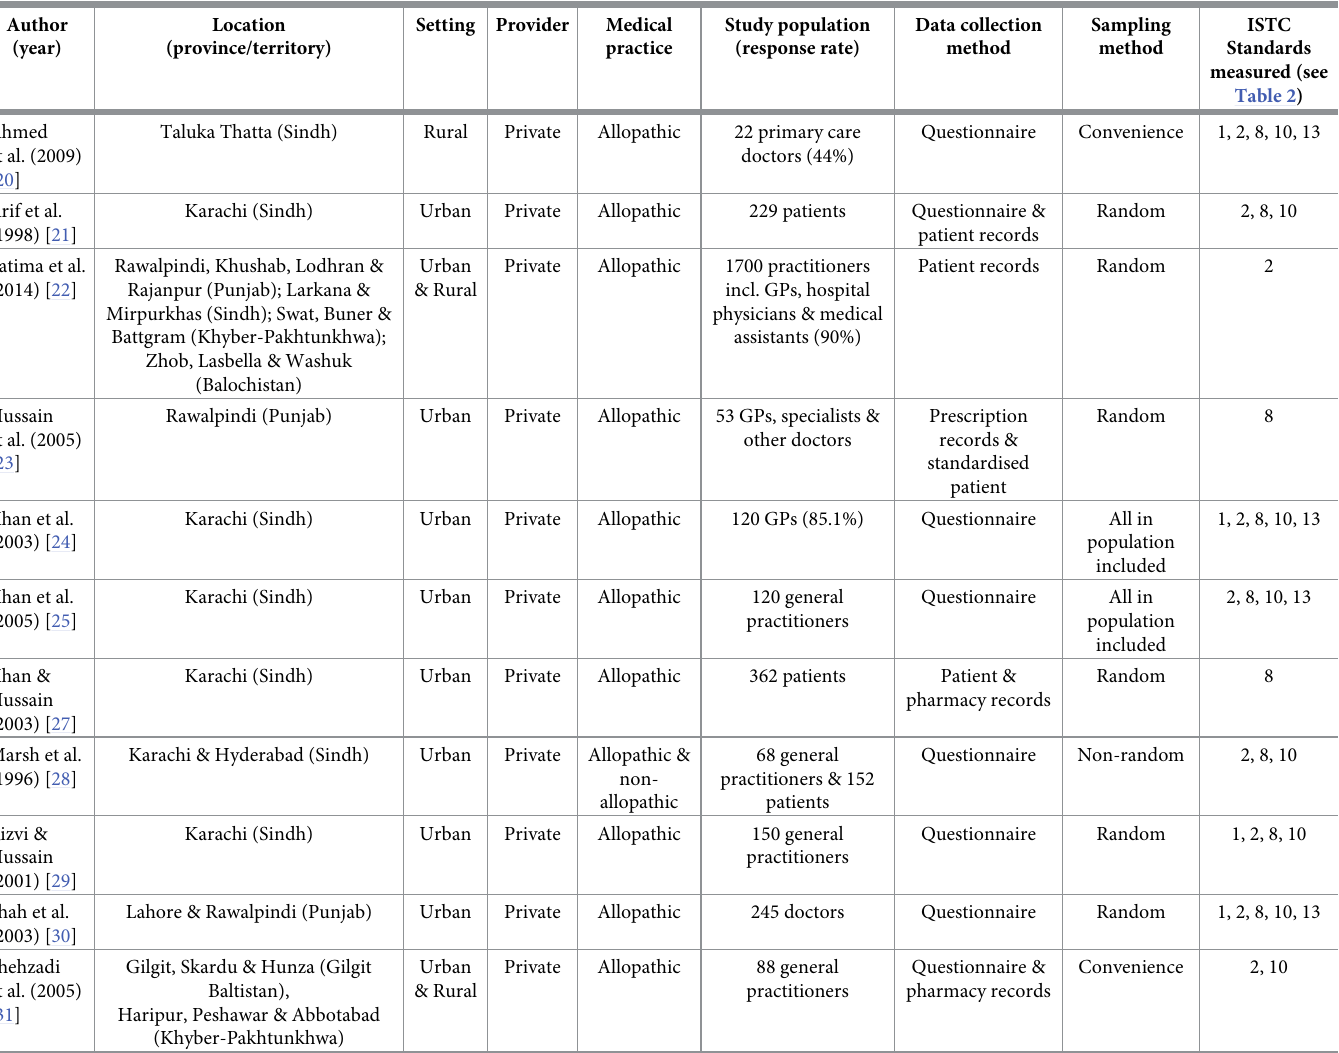
Table 1. Summary of data extracted from